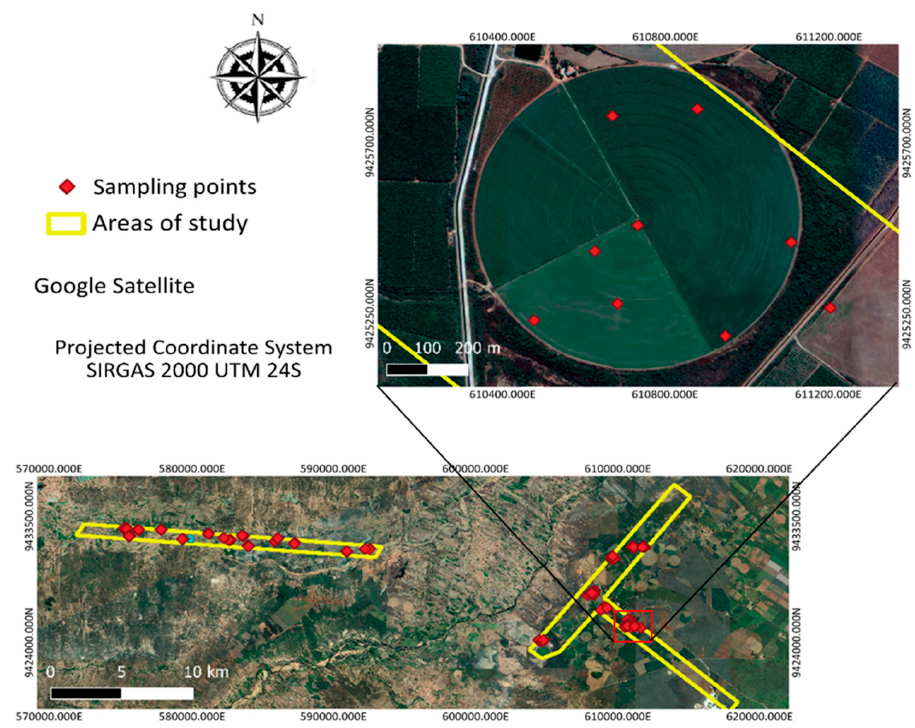
Figure 2. Location of soil collection points, and a detailed view of the distribution of the chosen samples.